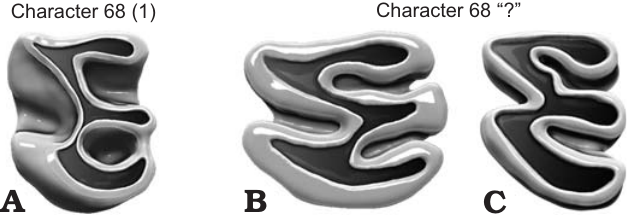
Fig. 4. Character state coding of character 68 of Verzi et al. (2014). “Metalophulid II in non-laminar m1–2”, as scored by these authors for several octodontoid taxa. A . Acarechimys minutissimus , scored as 68-1 (i.e., metalophulid II, “reduced, proximal portion forming a spur or absent, distal portion fused to metalophulid I so that the lingual end of the latter is usually expanded”). B . Euryzygomatomys , scored as “?”. C . Eumysops , scored as “?”, see also Thrichomys among others taxa scored as